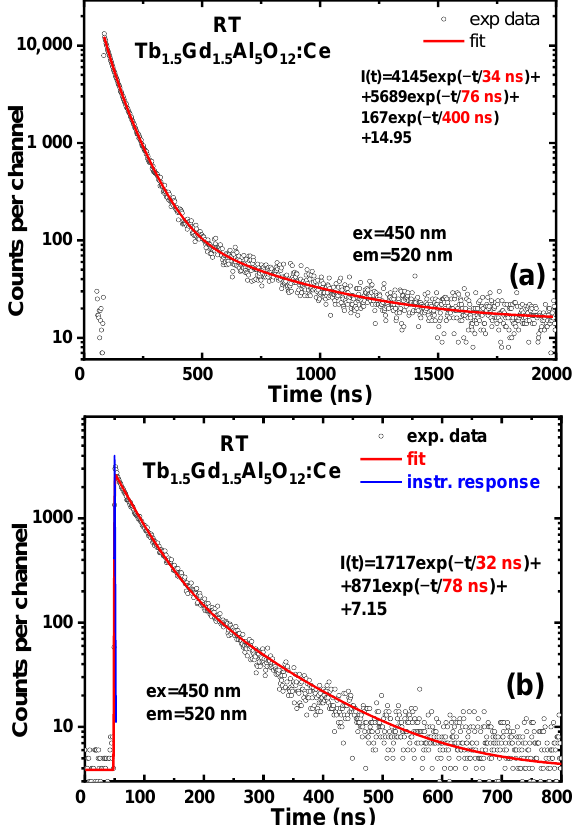
Figure 5. ( a ) RT decay time of Ce 3+ luminescence at 520 shown in μs time range; ( b ) RT prompt decay curves of the Ce 3+ luminescence recorded at 520 nm under excitation at 450 nm.